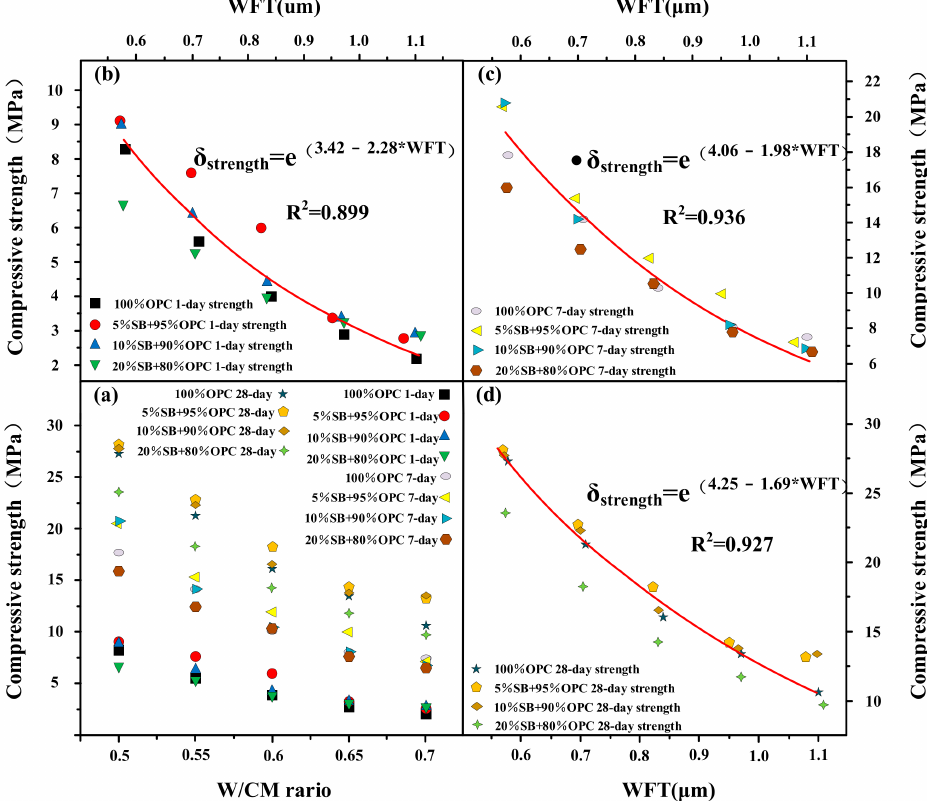
Figure 9. Compressive strength versus W/CM ratio ( a ) and WFT ( b – d